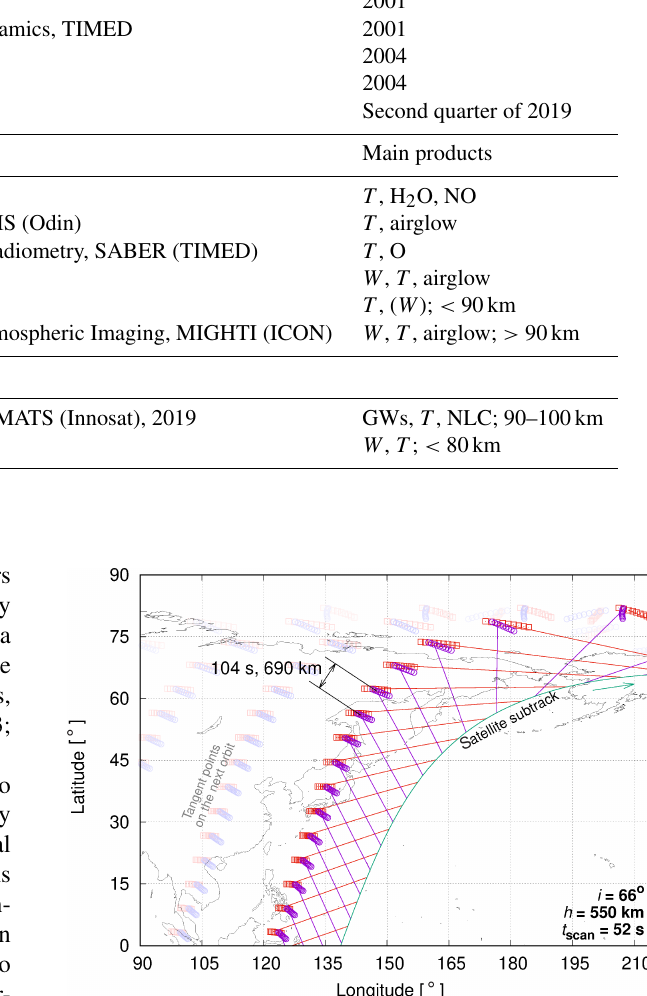
Table 1. Current and future satellites and instruments capable of measuring the MLT (60–110km). Satellites in operation Launch year Odin 2001 Thermosphere Ionosphere Mesosphere Energetics and Dynamics, TIMED 2001 Atmospheric Chemistry Experiment, ACE 2004 Aura 2004